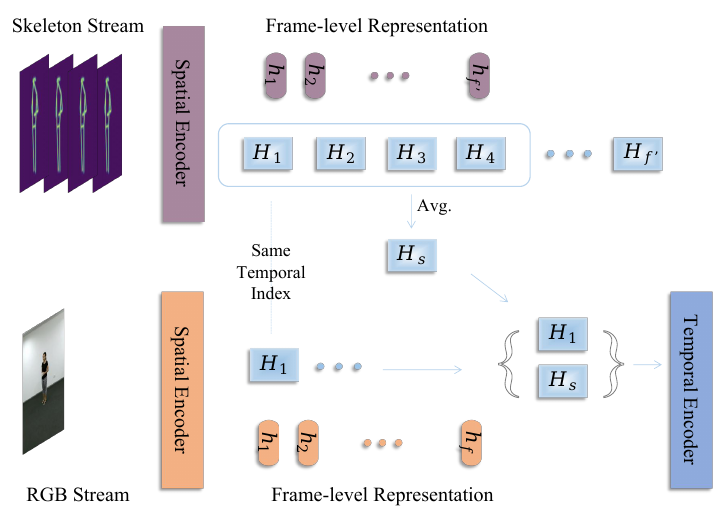
Figure 5. The details of the classification token fusion